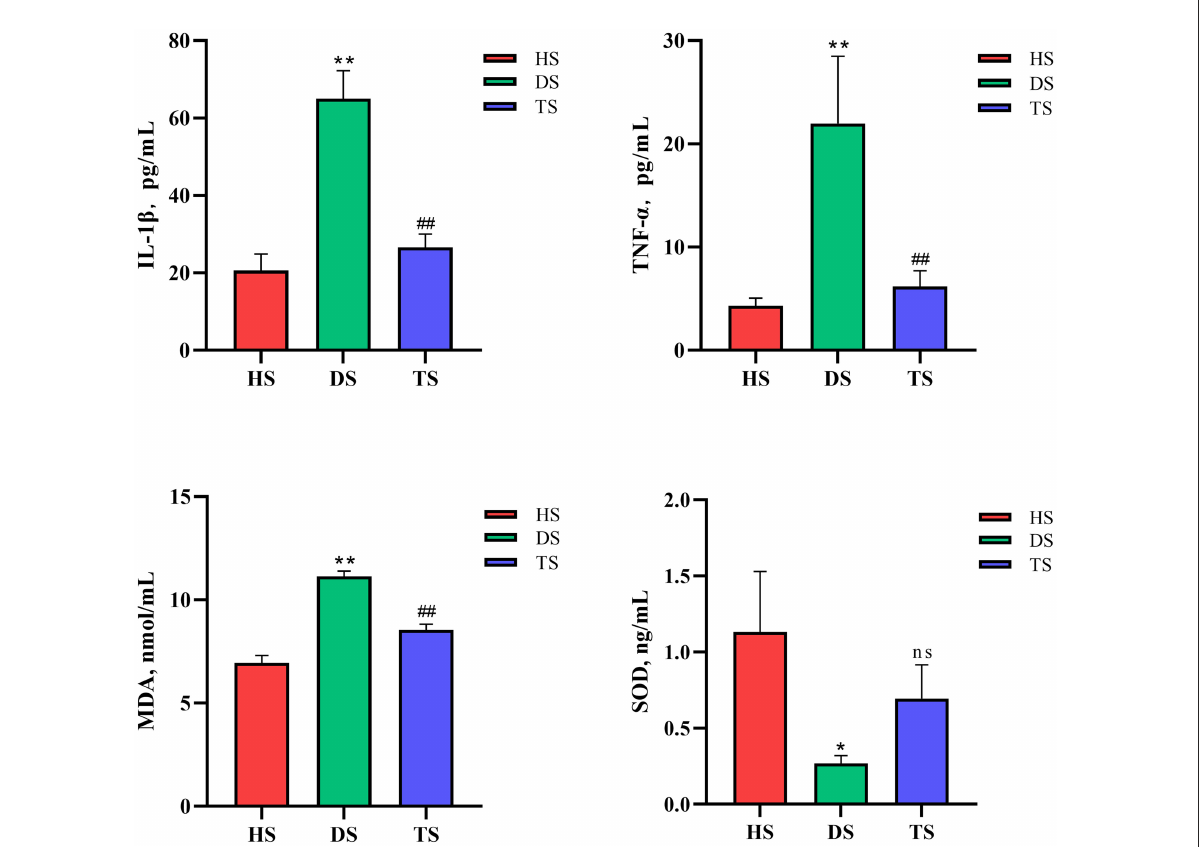
FIGURE2 Effect of Pueraria lobata polysaccharide (PLP) on the oxidative stress level and immune inflammatory cytokines. Expression of the IL-1 β , TNF- α , malondialdehyde (MDA) and superoxide dismutase (SOD). Each column represents a sample. Data are expressed as mean ± SEM, SEM means standard error of the mean, * P < 0.05, ** P < 0.01 DS vs. HS; ## P < 0.01 TS vs. DS. ns, no significant. HS, healthy calf fecal sample; DS, diarrheal calf fecal sample; TS, PLP treatment diarrheal calf fecal